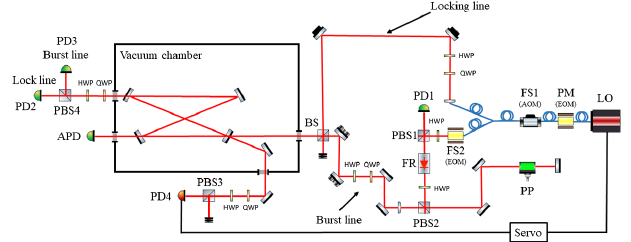
FIG. 5. Setup used for experimental validation of optimization